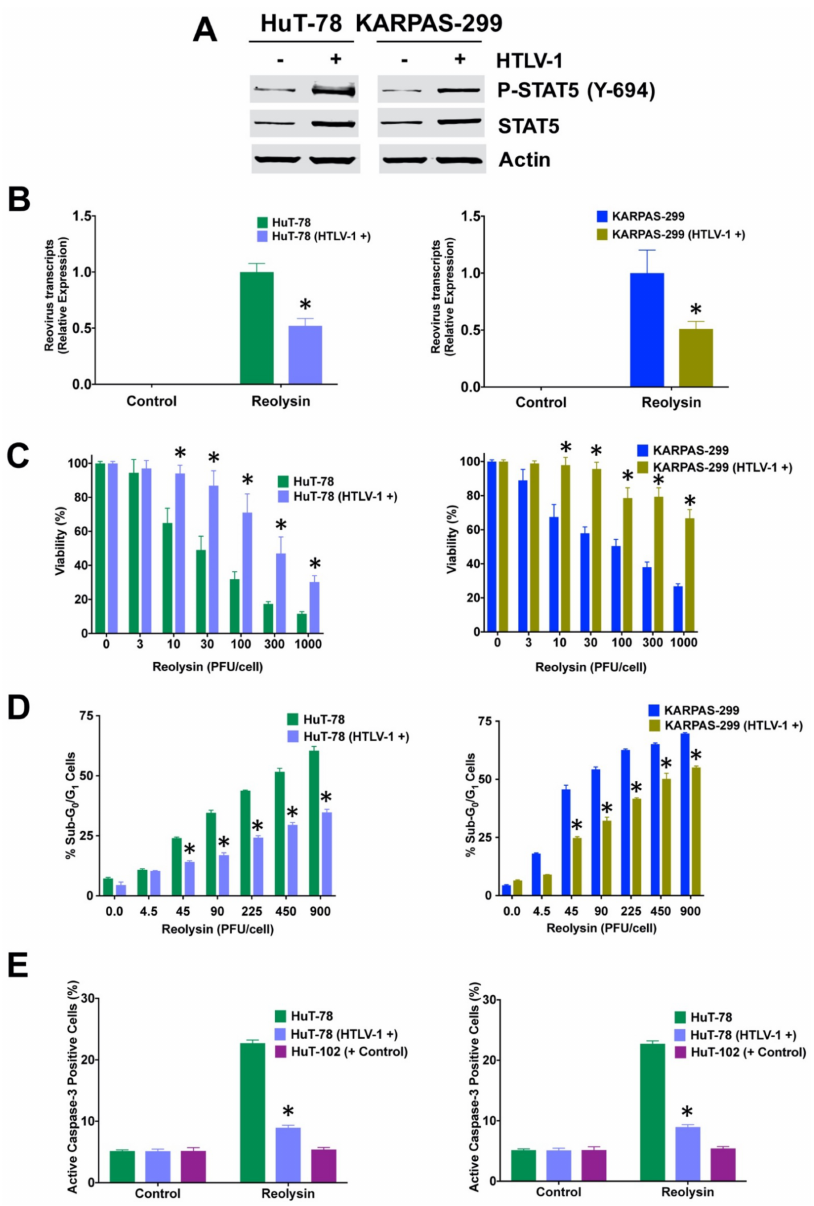
Figure 5. HTLV-1-infected TCL cells are less susceptible to Reolysin-induced cell death. ( A ) HTLV-1- infected TCL cells display upregulated expression of STAT5. Total and phospho-STAT5 levels were determined by immunoblotting in parental and HTLV-1-infected cells. ( B ) Quantification of reovirus levels in HTLV-1-negative and positive cells. Cells were treated with 180 PFU/cell Reolysin for 48 h. Levels of reovirus were quantified by qRT-PCR analysis. Transcript levels were quantified relative to Reolysin-treated HTLV-1-negative parental versions for each cell line. Mean ± SD, n = 3. ( C ) Reolysin is less effective at reducing TCL cell viability in the presence of HTLV-1. Parental and HTLV-1-positive cells were treated with the indicated concentrations of Reolysin for 72 h. Cell viability was measured by MTT assay. Mean ± SD, n = 3. ( D ) HTLV-1-transfected cells are significantly less sensitive to Reolysin-mediated apoptosis. Cells were treated with the indicated concentrations of Reolysin for 48 h and apoptosis was quantified by PI-FACS analysis. Mean ± SD, n = 3. ( E ) Reolysin-induced caspase-3 activation is reduced in the presence of HTLV-1. Cells were treated with 50 PFU/cell Reolysin for 48 h and active caspase-3 levels were quantified by flow cytometry. Mean ± SD, n = 3. * Indicates a significant difference between parental and HTLV-1-positive cells, p <